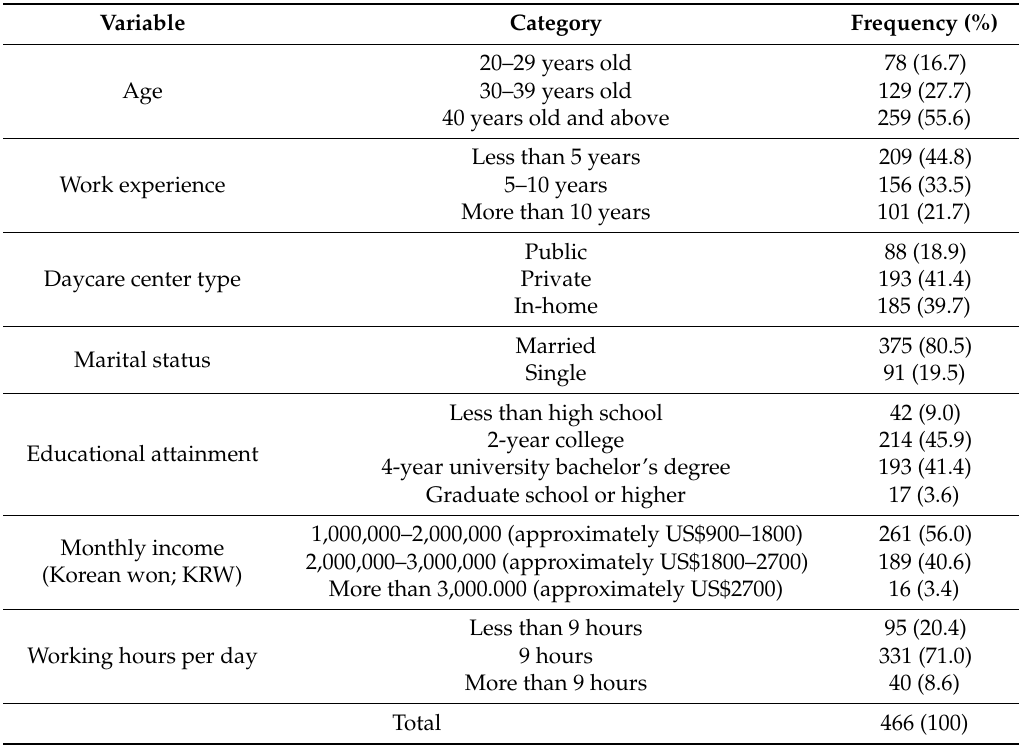
Table 1. Characteristics of the